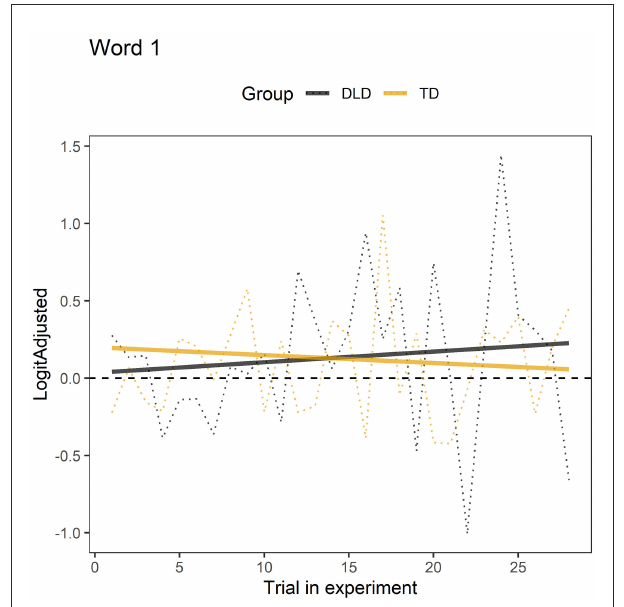
FIGURE6 Graph depicting looks towards the target picture per Group and Trial for Word1. The dotted line represents the actual data, the solid line represents the prediction of the statistical model.